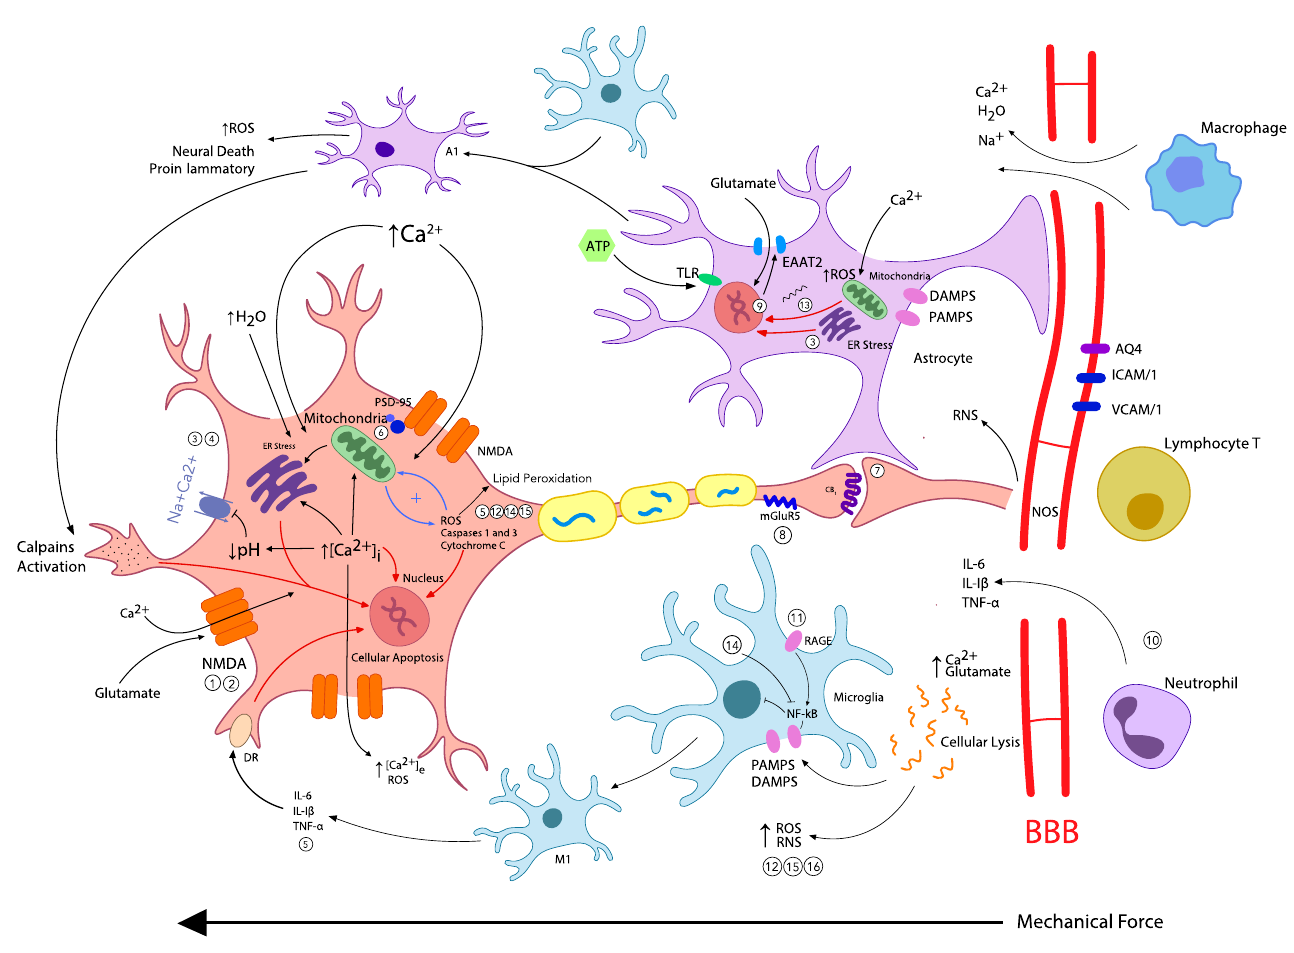
Figure 1. Illustration of pathophysiological events leading to excitotoxicity after TBI. BBB disruption leads to edema, changes in ionic homeostasis, and the migration of systemic immune cells. Release of intracellular contents in the medium activates microglia and astrocytes, enhancing OS, inflammation, and neural damage. Increase in extracellular [Ca 2+ ] and glutamate activates NMDAr, while mechanical activation and mechanoporation of NMDAr lead to an increase in [Ca 2+ ] i , creating an environment stressful to mitochondria, ER, and DNA, and a decrease of pH. Many pathways lead to cellular apoptosis: organelle stress and the activation of caspases, calpains, and death receptors. In black: events related to the activation and flux of ions. In red: pathways related to cellular apoptosis. Numbers address potential therapies listed in Table 1. [Ca 2+ ] i : concentration of intracellular calcium; [Ca 2+ ] e : concentration of extracellular calcium; BBB: blood–brain barrier; ROS: reactive oxygen species; RNS: reactive nitrogen species; NMDAr: N -methyl- D -Aspartate receptors; TLR: toll-like receptor; ATP: adenosine triphosphate; EAAT2: excitatory amino-acid transporter 2; NOS: nitric oxide synthase; DAMPS: damage-associated molecular patterns; PAMPS: pathogen-associated molecular patterns; AQ4: aquaporin-4; ICAM1: intercellular cell adhesion molecule-1; VCAM1: vascular cell adhesion molecule-1; mGluR5: glutamate metabotropic receptor; RAGE: receptor for advanced glycation end products; ER: endoplasmic reticulum; PSD-95: postsynaptic density protein-95; DR: death receptor.